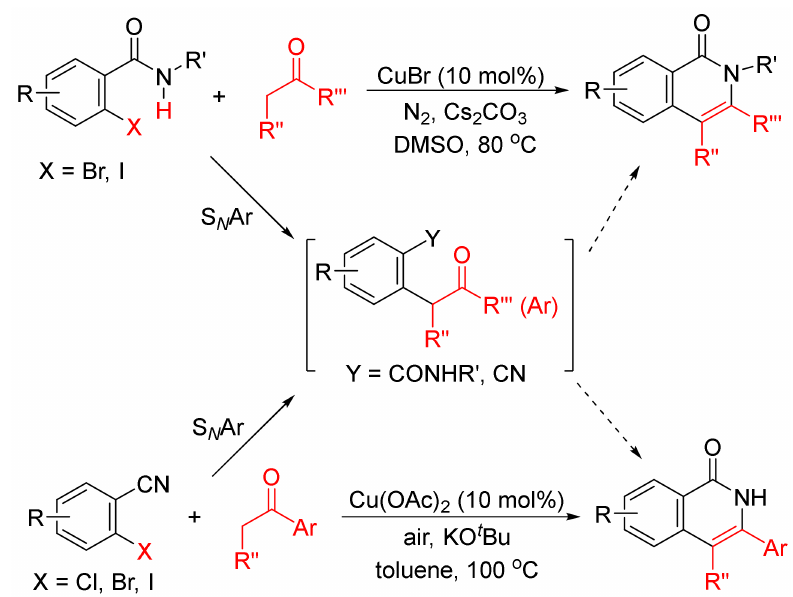
Scheme 5. Copper-catalyzed isoquinolone formation including S N Ar